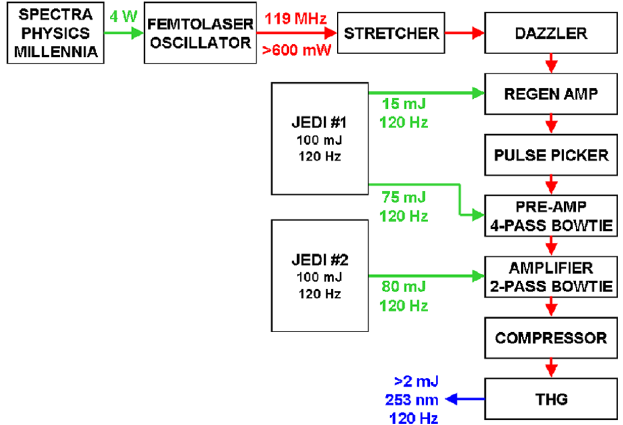
FIG. 2. (Color) Block diagram of the gun drive laser designed and built by Thales Lasers .